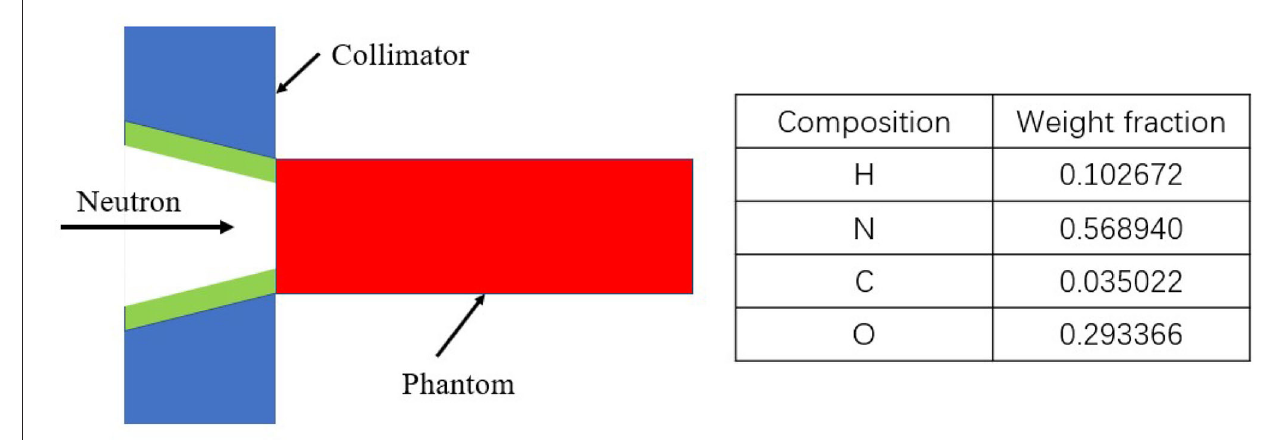
FIGURE 3 | Geometry and composition of the phantom used in dose calculation.